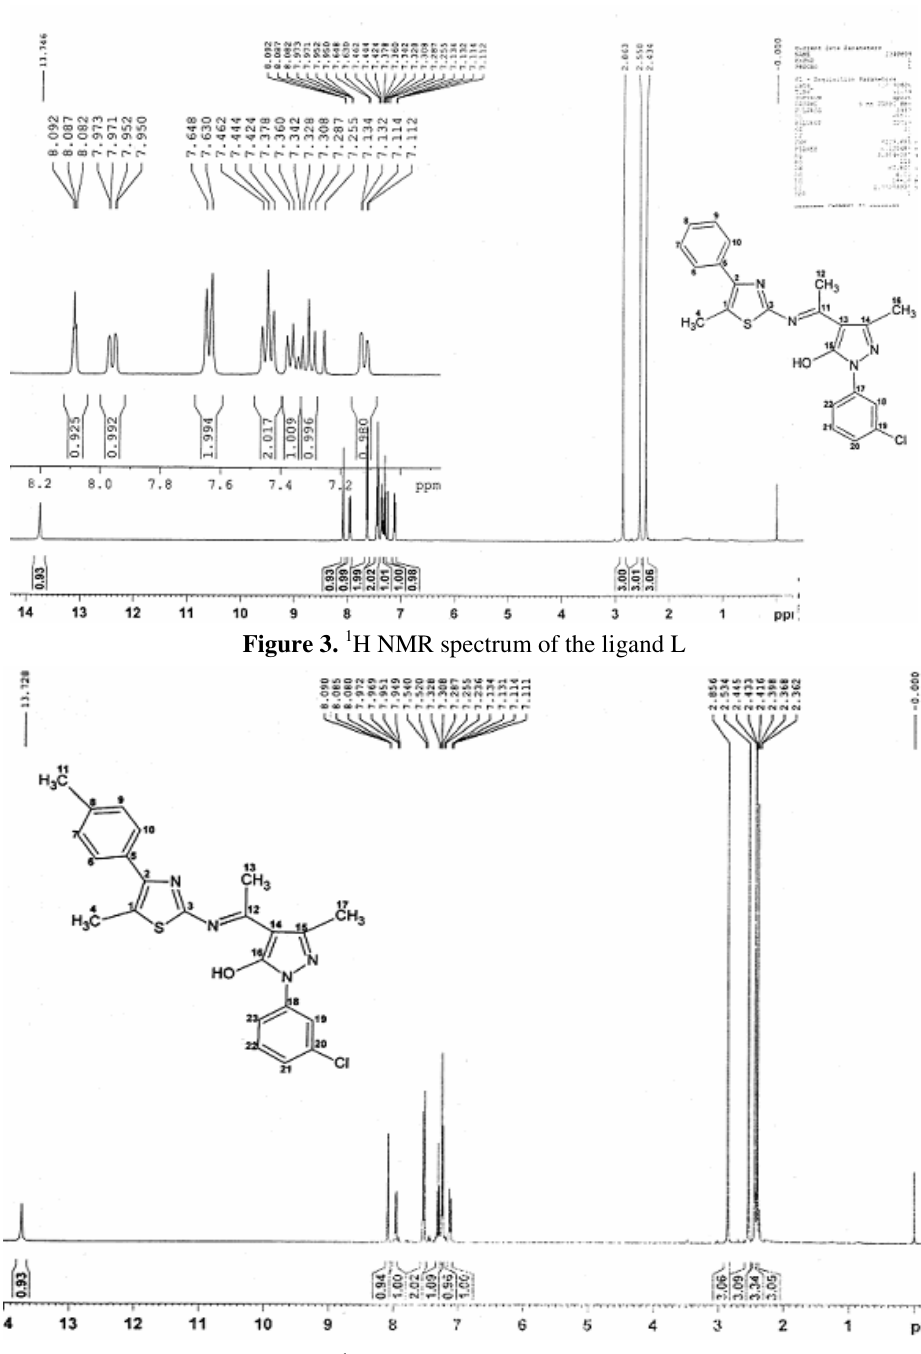
Figure 3. 1 H NMR spectrum of the ligand L